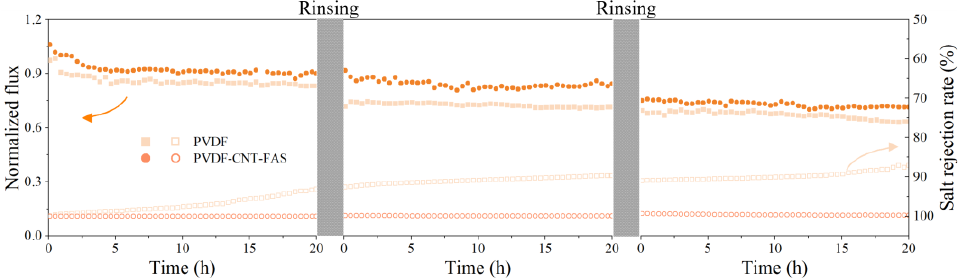
Figure 1. The normalized flux and salt rejection rate in the treatment of simulated shale gas wastewater. The MD experiments were conducted using simulated wastewater (1 M NaCl, 0.05 mM SDS with 160 ppm mineral oil) in cycles of 20 h. The membrane was rinsed with water at the end of each cycle until the washing solution conductivity of both the feed and permeate side dropped to 10